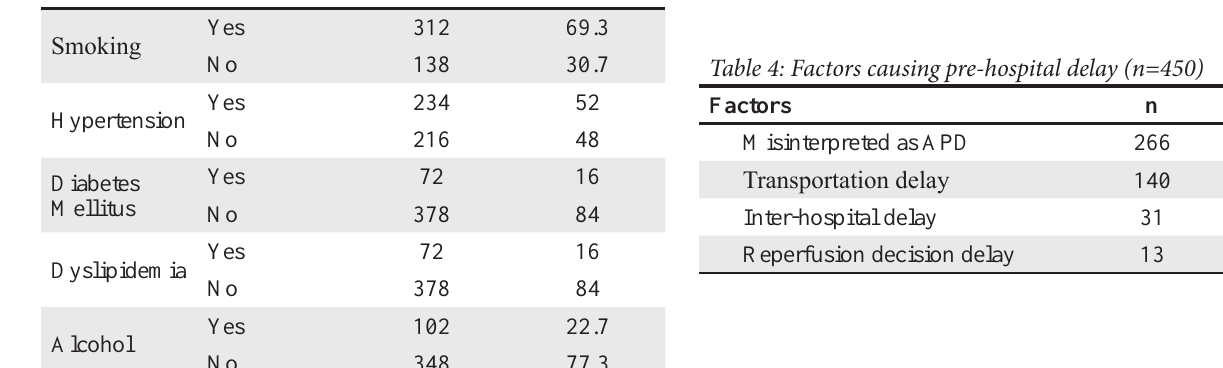
Table 2: Exposure of MI patients to risk factors (n = 450) Characteristics